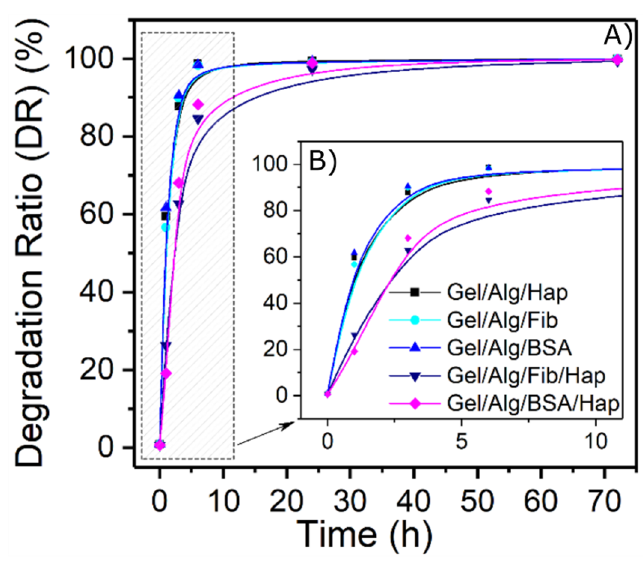
Figure 4. ( A ) Degradation over time of the hydrogels. ( B ) Close-up of the first 10 h of degradation.